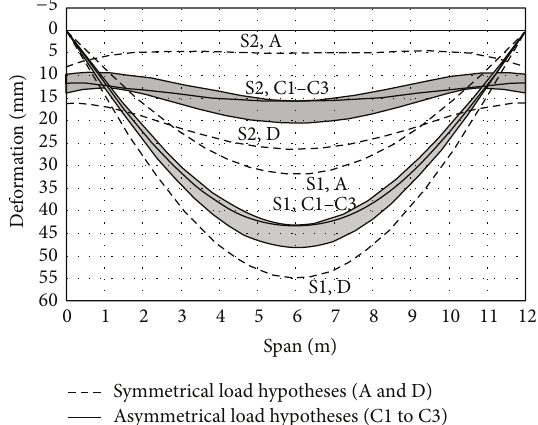
Figure 12: Deformation hypotheses (A), (C1) to (C3), and (D), F1 structural floor, sections (S1) and (S2).